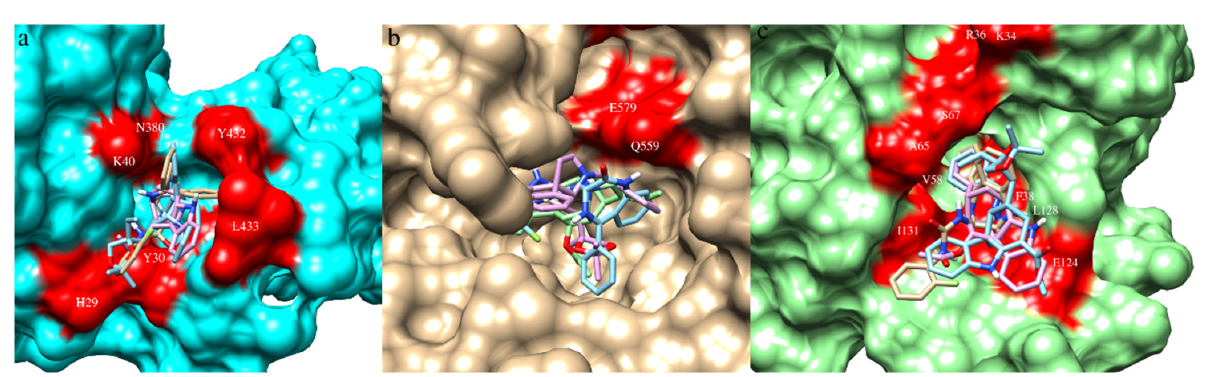
Figure 4. Molecule CARS0358 (blue), RASE0125 (pink), and ND_nw_193 (bisque) docked inside the respective ligand-binding sites (red colored) of NiV-F ( a ), NiV-G ( b ), and NiV-N ( c ) . Figure 3. Two-dimensional (2D) images of molecules CARS0358 ( a ), RASE0125 ( b ), and ND_nw_193 ( c ) .